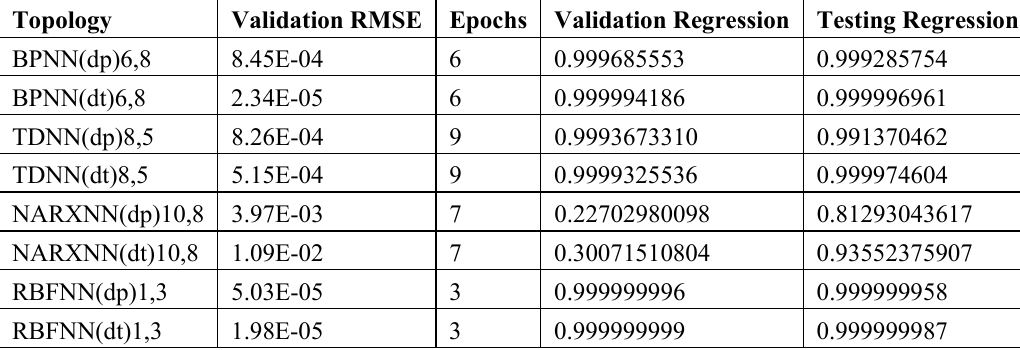
Table 6. Performance of best topologies with added inputs.